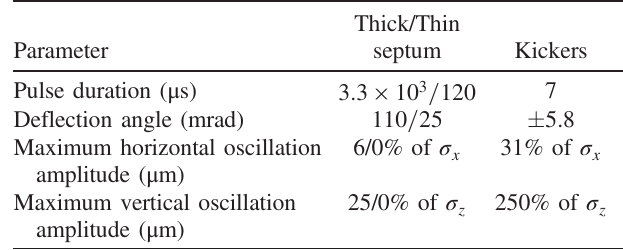
TABLE IV. Optimized characteristics and perturbations of the injection